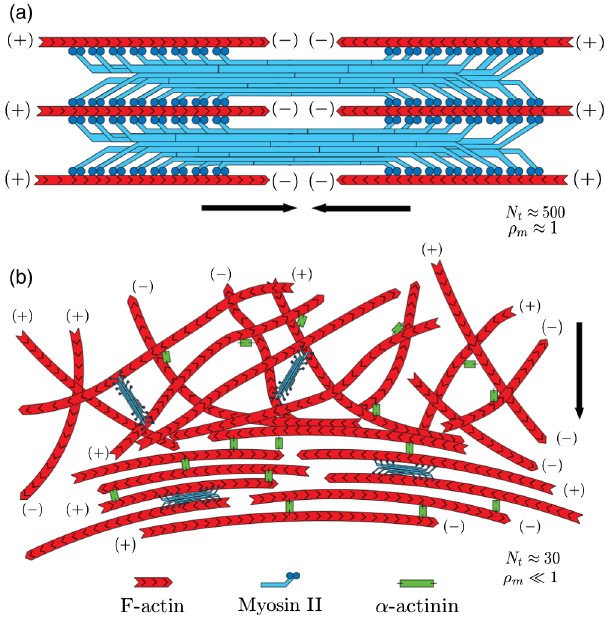
FIG. 1. Actomyosin contractility mechanisms in a variety of cell types. (a) In a muscle sarcomere, filamentous actin ( F -actin) are aligned in bands of opposite polarity such that a bipolar myosin II filament can walk towards the actin filament ’ s plus ends, generating maximal contractile force, shown as black arrows. The motor filaments also contain hundreds of heads, which are able to continuously generate force on the filaments and maintain attachment as they hydrolyze ATP to produce mechanical work. (b) In a nonmuscle actomyosin network, filaments are distributed in a random geometric fashion through- out the cytoskeleton. The myosin II filaments in a nonmuscle actomyosin system are also smaller (number of heads per side of ≈ 30 [8]) and highly transient (the duty ratio bipolar filament N t ≪ 1 ) of bound to unbound states of the motor filament ρ m ≈ 500 , ρ ≈ 1 ), but compared to their muscle counterparts ( N t m can form disordered arrangements of locally antiparallel actin filaments. Motor filaments of this nature are responsible for stress fiber formation via compression of a fragmented lamellipodial actin